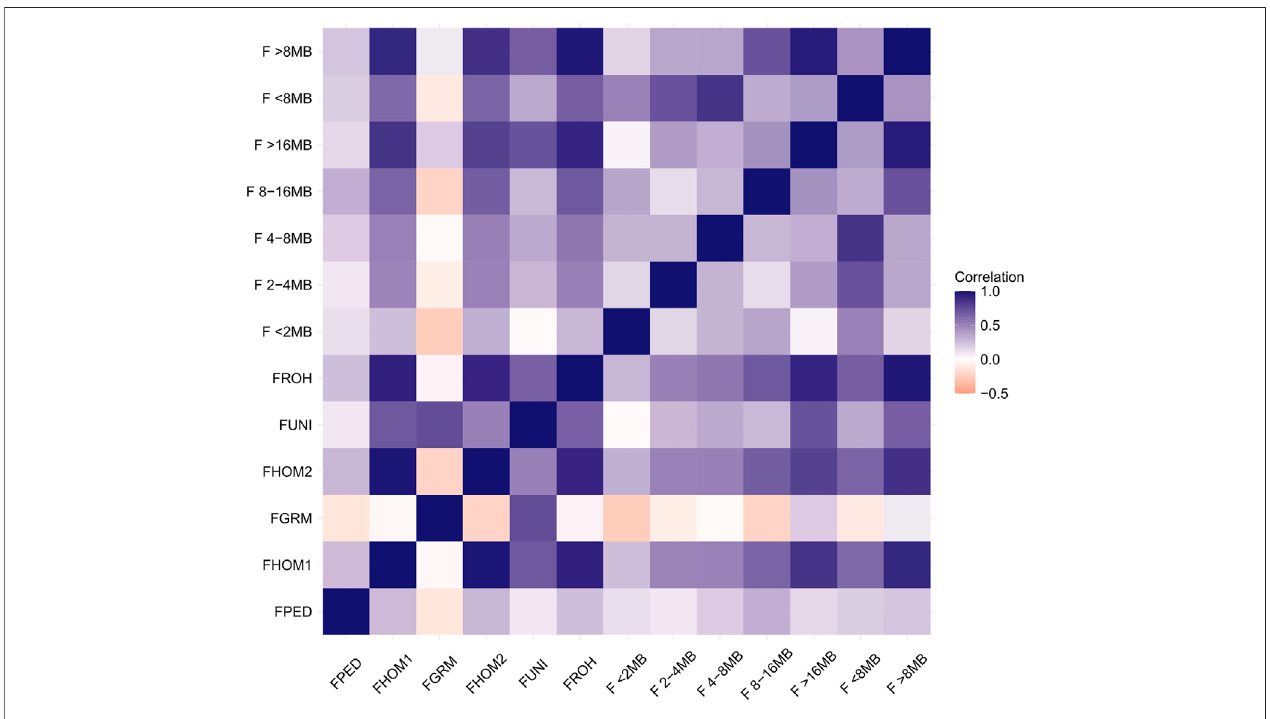
FIGURE 3 | Correlation among inbreeding estimation methods.